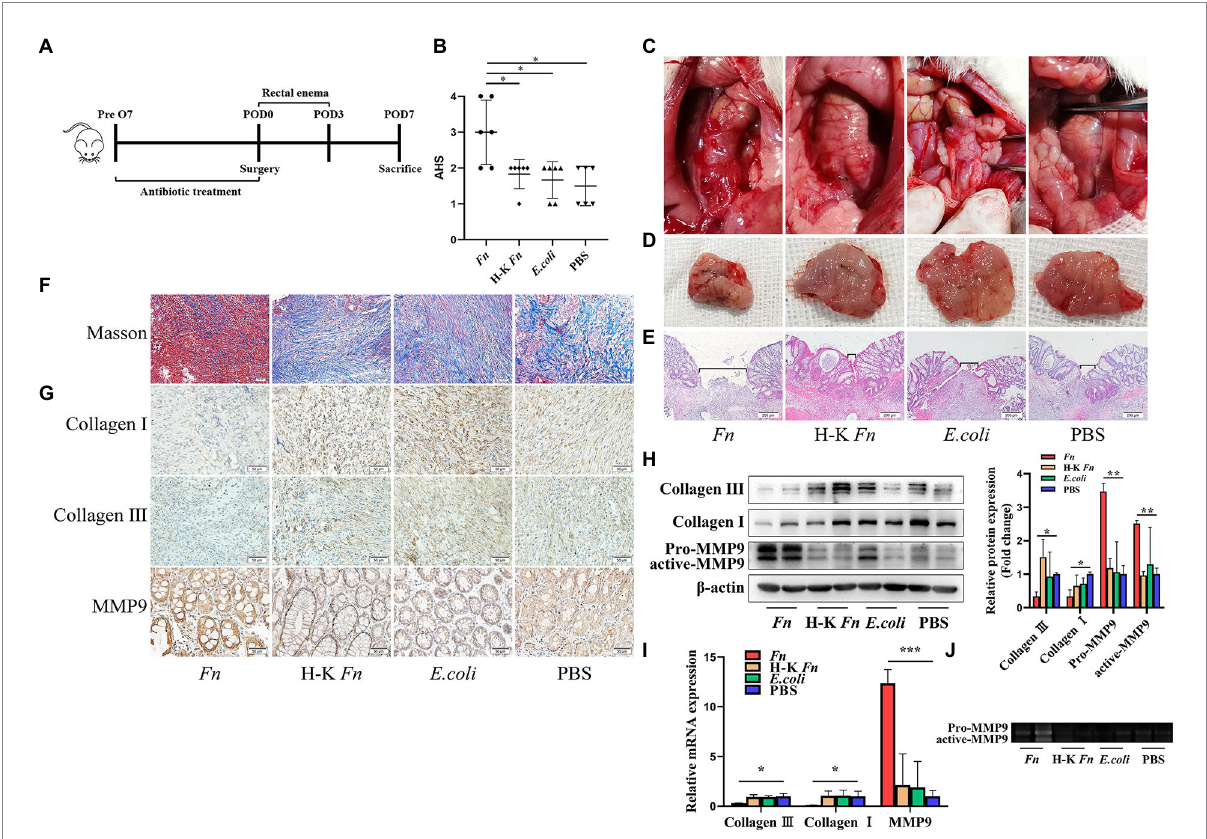
FIGURE 2 Fn degrade collagen by stimulating the MMP9 expression of epithelial cells and contribute to AL. (A) Sketch of anastomosis model. Rats were assigned randomly to the following treatment groups: PBS rectal enema (PBS group); Fn rectal enema ( Fn group); Heat-killed Fn rectal enema (H-K Fn group); E.coli rectal enema ( E.coli group). (B) The AHS of four groups (n = 6 per group). (C) Gross inspection of the anastomotic healing. Only Fn group rats have anastomotic dehiscence. (D) Excised and exposed suture lines of anastomotic sites. All suture lines are grossly